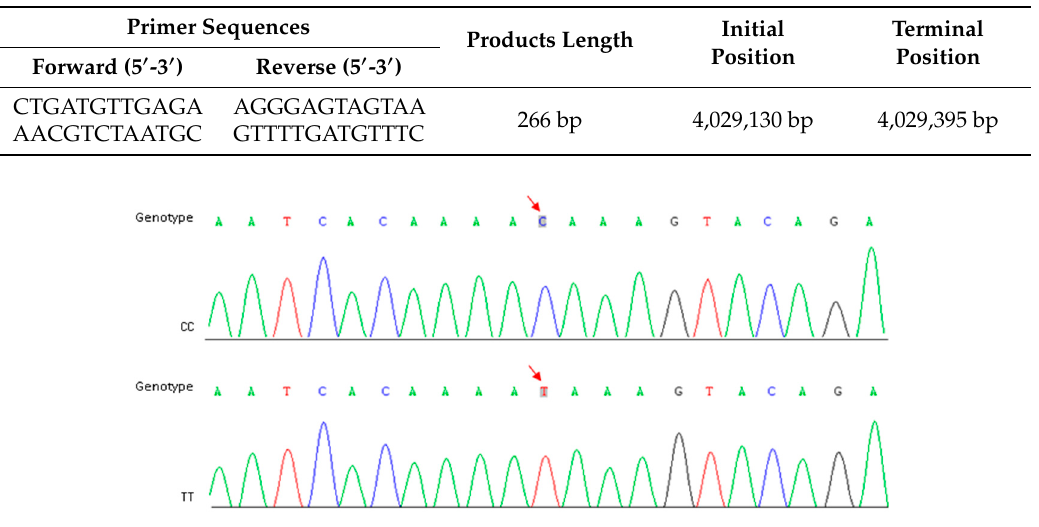
Table 4. Allelic variation of SNP-5 among cauliflower breeding lines detected in the present study.